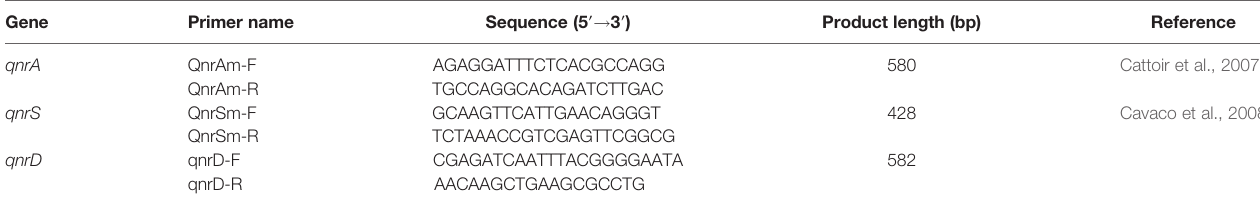
TABLE 1 | Characteristics of primers used for the ampli fi cation of selected fl uoroquinolone resistance genes by the PCR